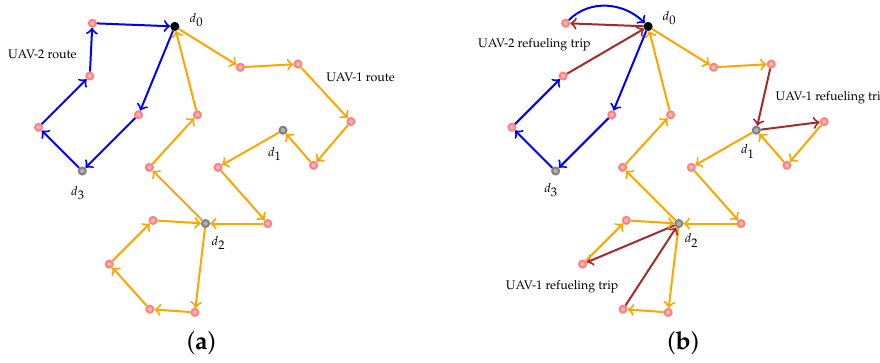
Figure 1. Illustration of a feasible first-stage solution and recourse action for a particular realization of the uncertainty. ( a ) A feasible first-stage solution to the two-stage FCMURP with two UAVs; the first-stage routes for the UAVs correspond to the ‘here-and-now’ decisions. ( b ) A feasible recourse action for the two-stage FCMURP with two UAVs; for a given realization of the fuel consumed by any vehicle to traverse an edge, the refuel trips (colored in brown) are added to the first-stage